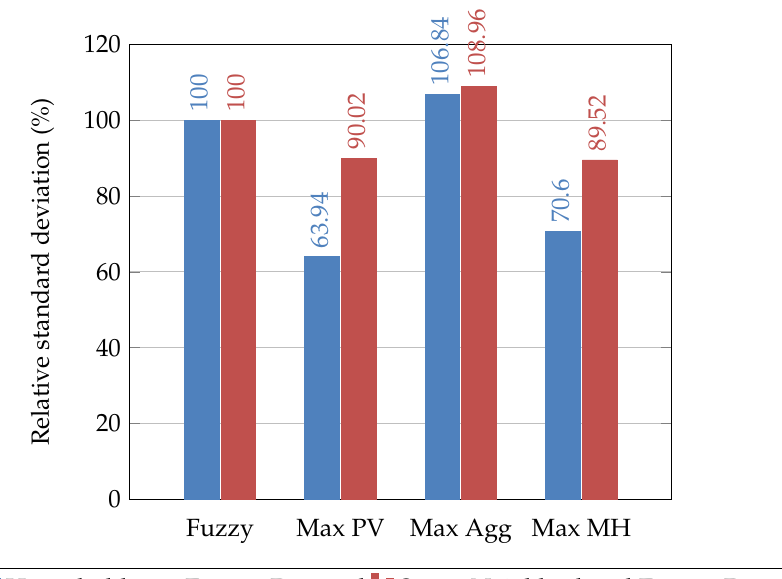
Figure 11. Relative standard deviations of both MH system and Smart Neighborhood energy demand.